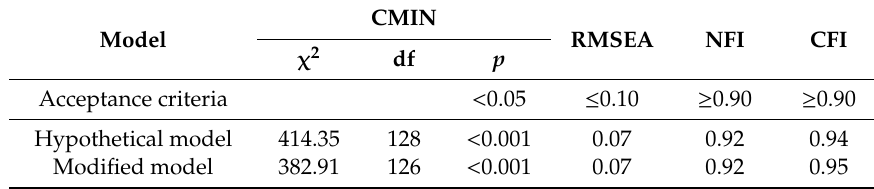
Table 2. Comparison of fit of the modified and hypothetical models.